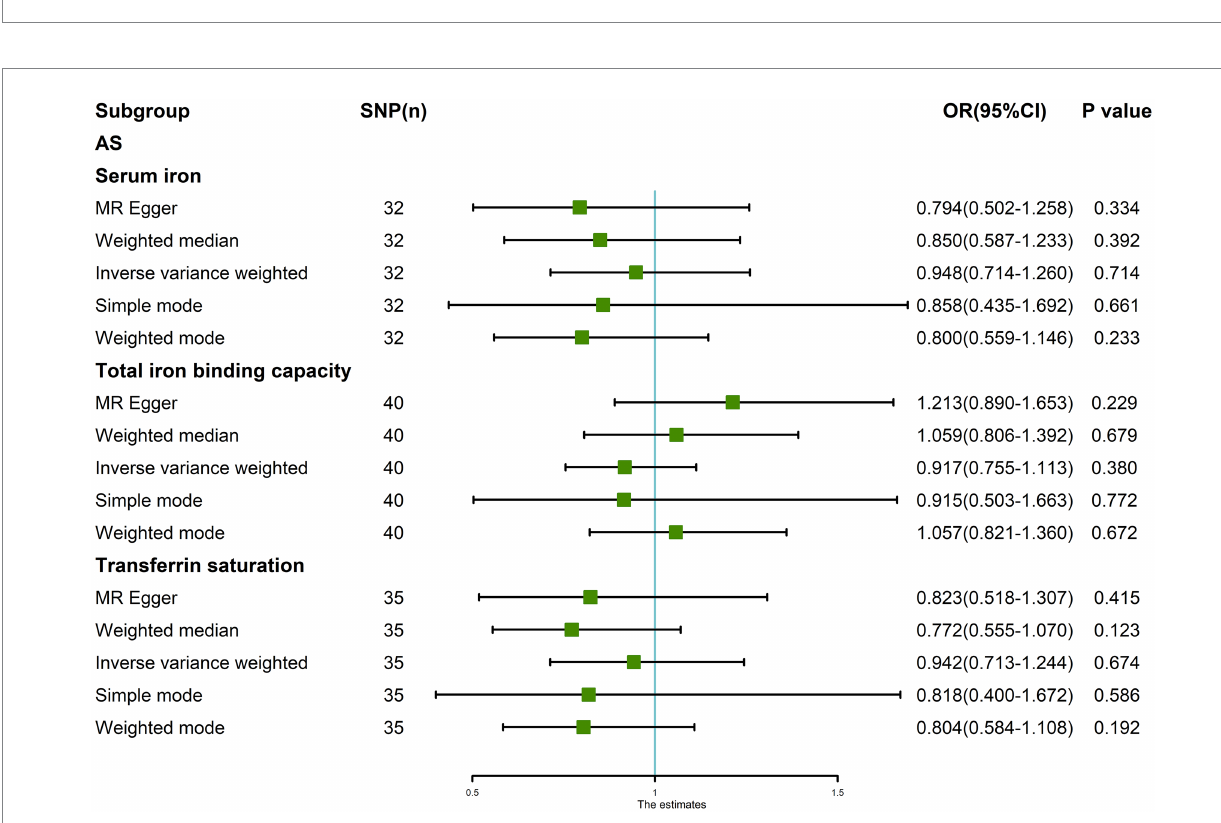
FIGURE 6 MR analysis results of the three exposures (serum iron, total iron binding capacity, transferrin saturation) and outcomes (ankylosing spondylitis) after exclusion of outlier SNPs detected by MR-PRESSO.